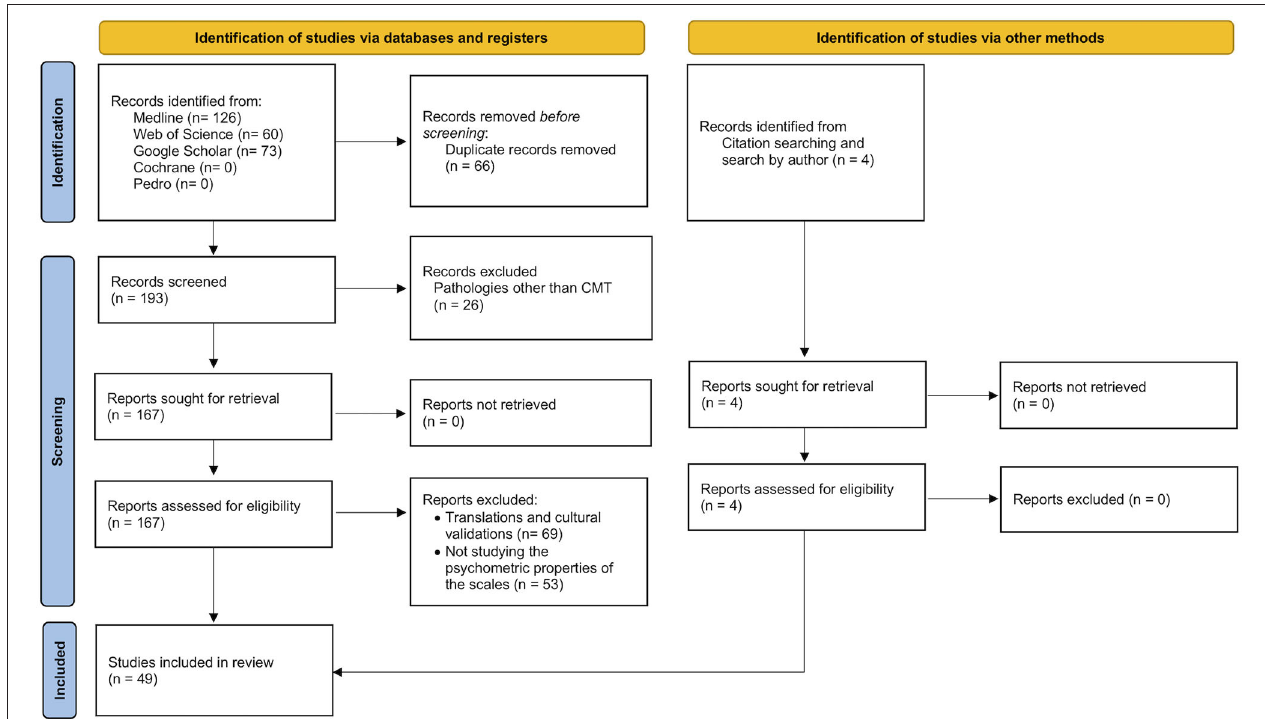
FIGURE 2 | Flow diagram of the selection process for studies assessing the psychometric properties of the scales identified previously.